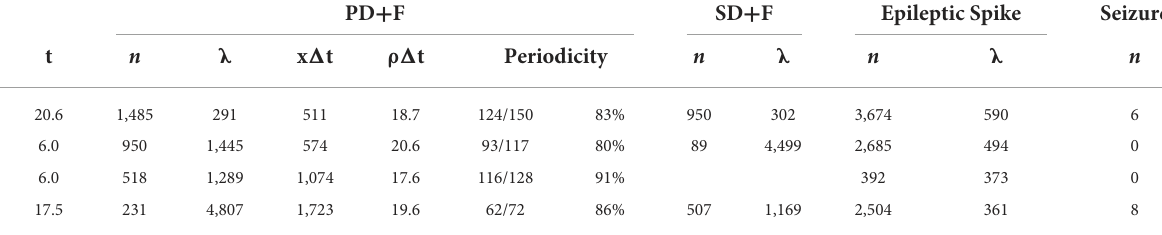
TABLE 3 Descriptive statistics of (inter)ictal activity for each